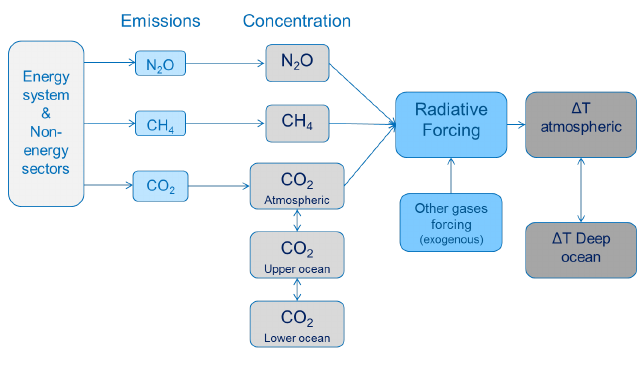
Figure A2. TIAM climate